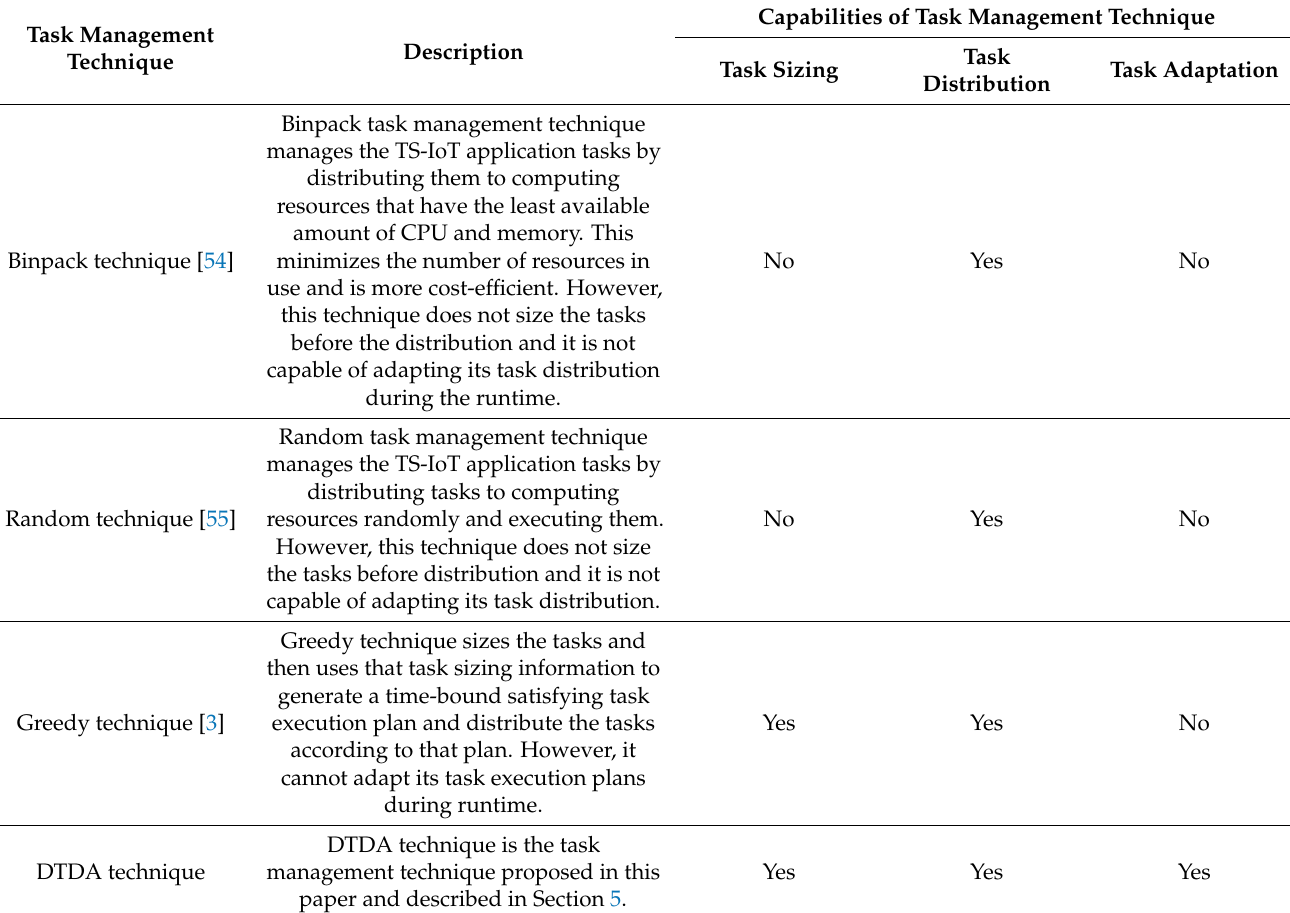
Table 4. Task management techniques used for experimental